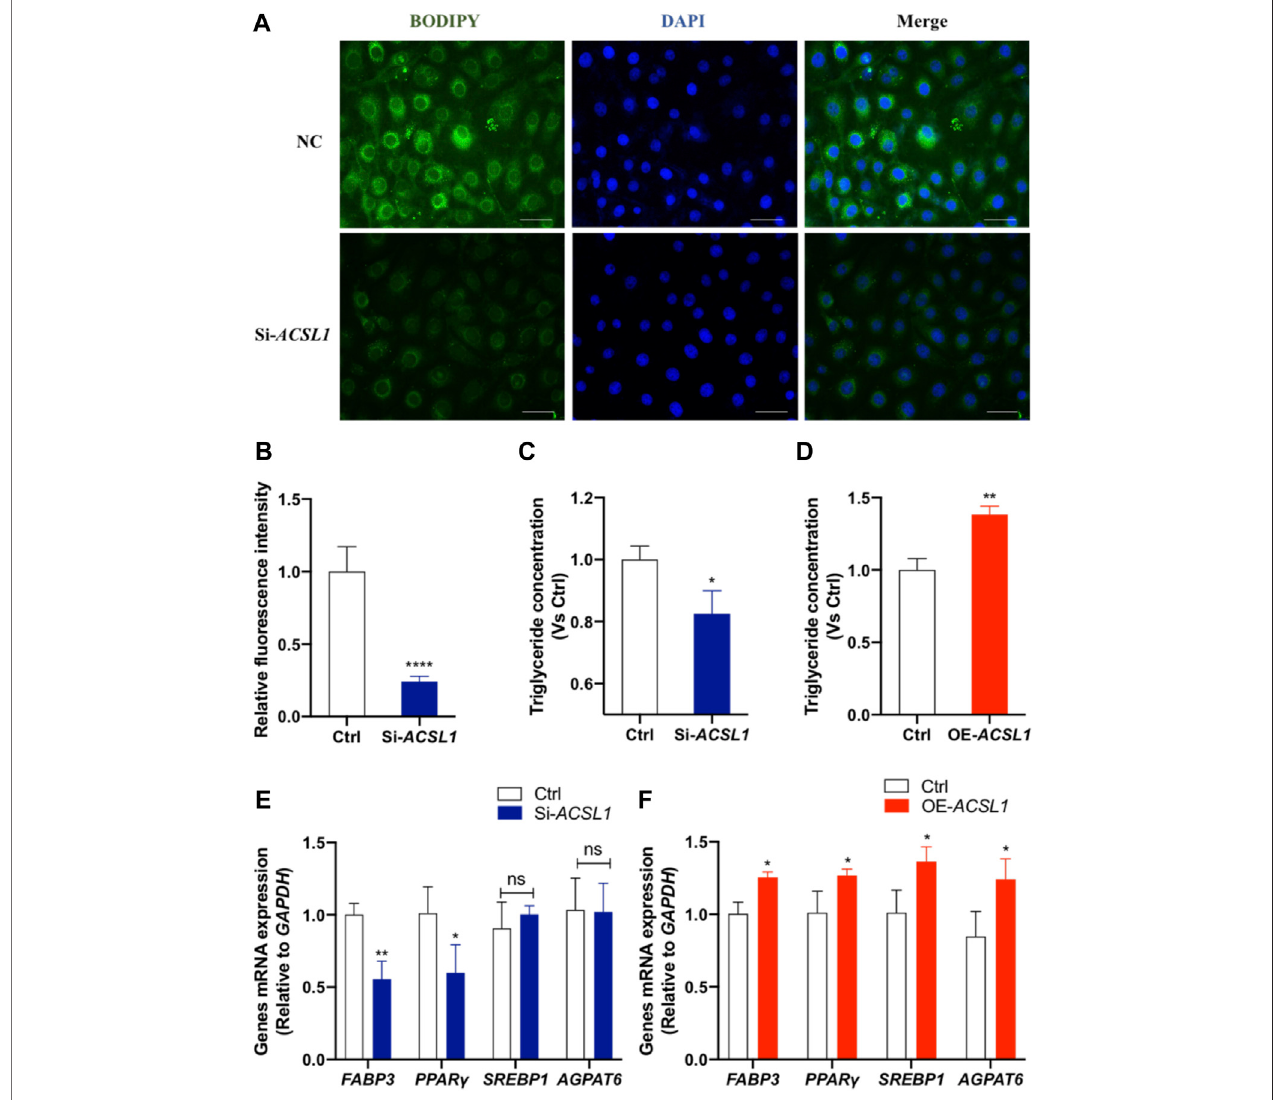
FIGURE 5 | ACSL1 regulated lipogenesis and triglyceride synthesis in MAC-T cells. (A) MAC-T cells were transfected either with ACSL1 siRNA or negative control for 72 h. Bodipy staining (green) was used to indicate the lipid distribution, and nuclei were stained by DAPI (blue). Scale bar: 20 µm; (B) Quanti fi cation of BODIPY + fl uorescent signal density; (C,D) Triglyceride concentration was detected in the cell lysate. Triglyceride concentration was normalized by control (Ctrl); (E,F) mRNA expression of lipid metabolism – related genes after ACSL1 knockdown or overexpression, and GAPDH was used as the inner control. * p < 0 .05, ** p < 0.01, and *** p < 0.0001, ns: nonsigni fi cant